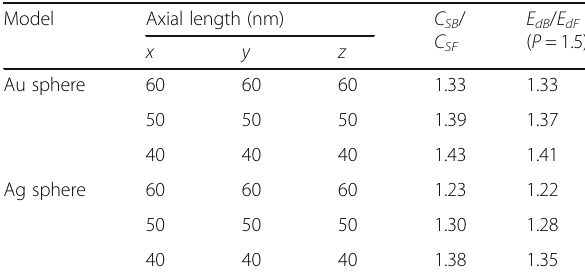
Table 5 Simulated C SB / C SF and calculated E dB / E dF using Eq. (4) when P equals 1.5 of different sizes and material of spherical NPs when n 2 fixed as 1.5